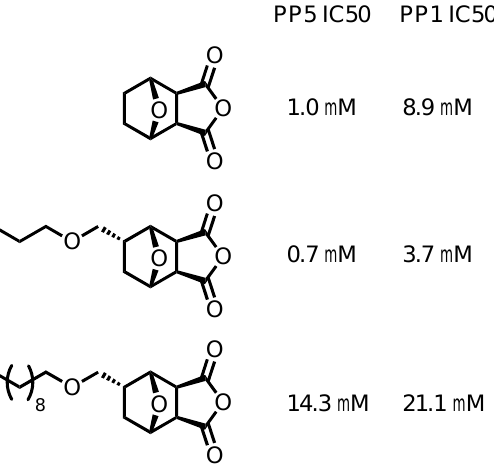
Chart 1. Activity and selectivity of norcantharidin against two derivatives [7].